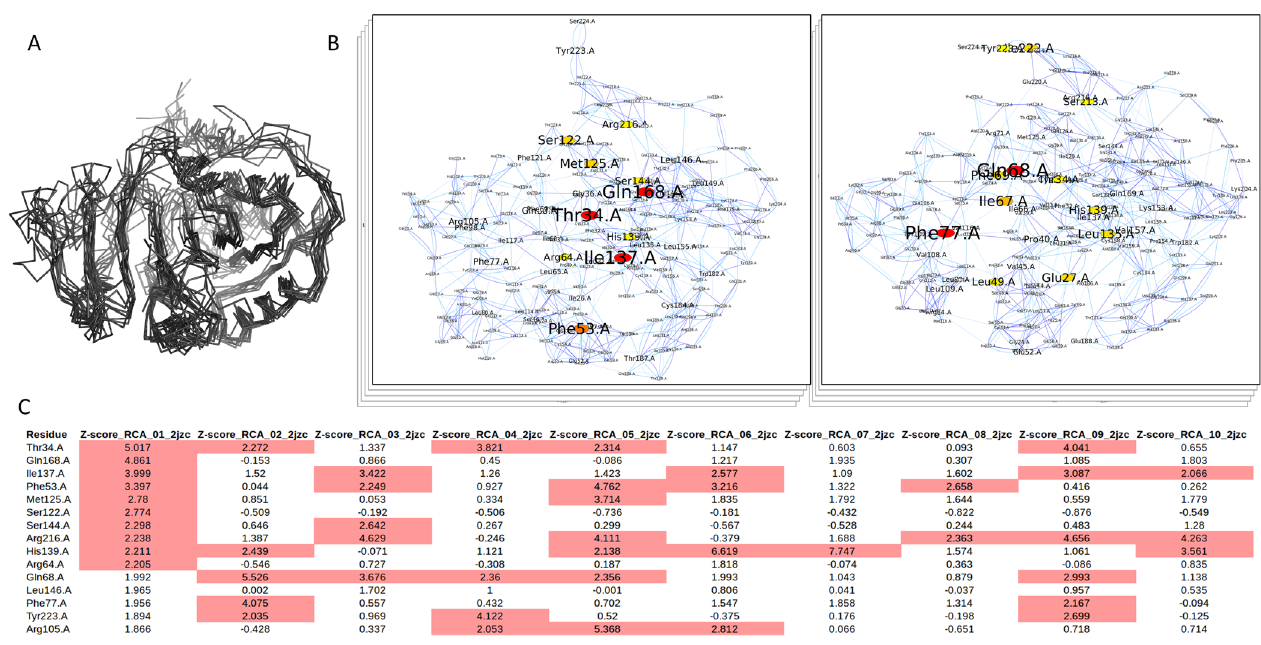
Figure 1. Residue centrality analyses (RCAs) of NMR conformers. ( A ) Overlapped structure of the 10 conformers used to generate the residue interaction networks (RINs) for ALG13 (PDB ID 2JZC) in ribbon representation. ( B ) The RINs on which RCAs were performed; central residues are colored from yellow (Z-score = 2) to red (Z-score ≥ 4), labels and node sizes are adapted as functions of the Z-scores: the higher, the bigger; only the first two RINs of the ten calculated are shown. ( C ) Final result table, which contains the centralities of all the networks, sorted by descending order of Z-scores of the first conformer; Z-scores considered as relevant (Z-score ≥ 2) have a pink background; only the first 15 residues are